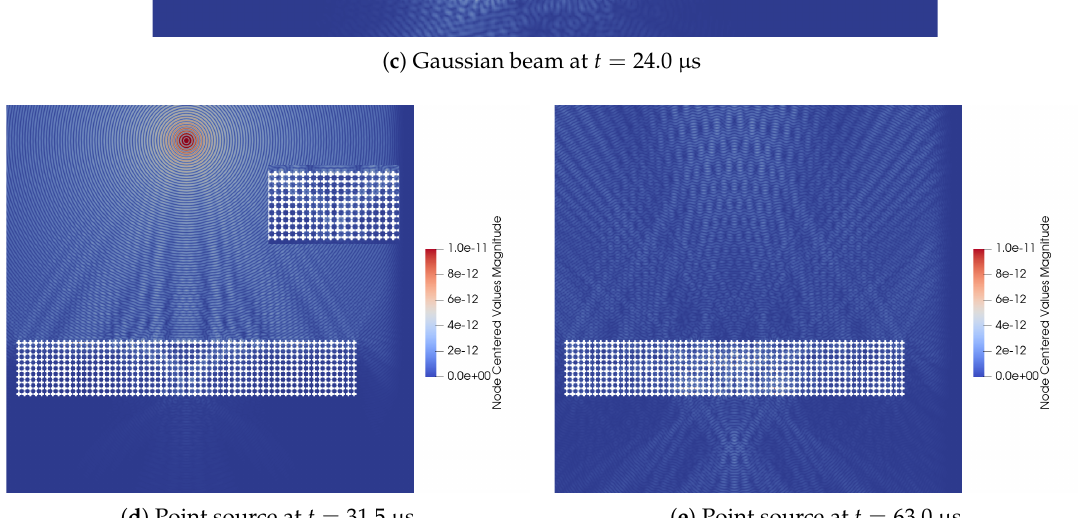
Figure 7. Scattering of a shear-dominated Gaussian beam at an angle of incidence α = 6 ◦ and a point source at (0, 40mm), both with centre frequency f = 3.3 MHz. Panels ( a , b ) show the IFC diagram (and its magnification); the red asterisk represents the intersection point of the Gaussian beam propagation direction and the isofrequency contours. Panels ( c – e ) show the magnitude of the displacement field at different times in the FE simulation, with the total time being T = 120 µ s. The inset of panel ( d ) is a magnification of the centre of the